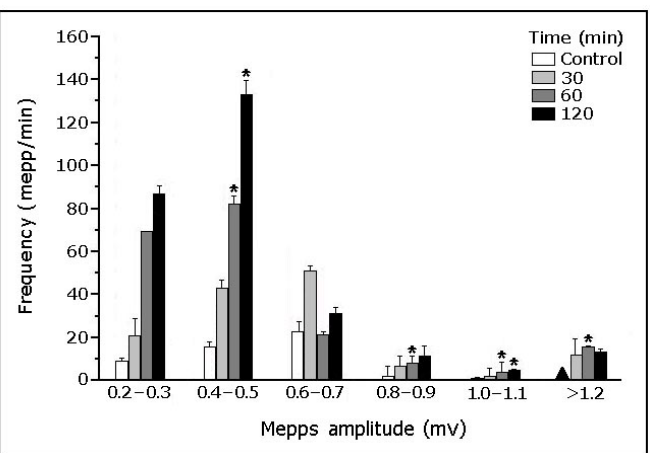
Figure 6. B. n. pauloensis venom (20 µ g/ml) effect on MEPPs frequency and amplitude in mouse diaphragm after 30, 60, and 120 min incubation compared to Tyrode control (white columns). The columns indicated by an asterisk are significantly different from control responses. Symbol ( ▲ ) on the X-axis indicates non-existent reading of bioelectric potentials. Note that 60 min after venom addition to the bath, an evident increase in MEPPs frequency is observed (p<0.05). Each point represents mean ± S.E.M. of four